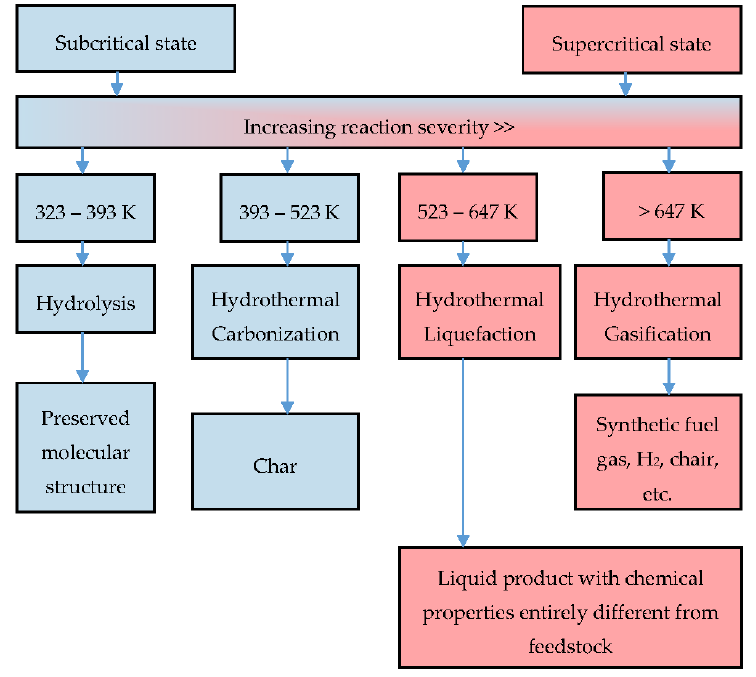
Figure 2. Regions at the subcritical and supercritical states in hydrothermal process.